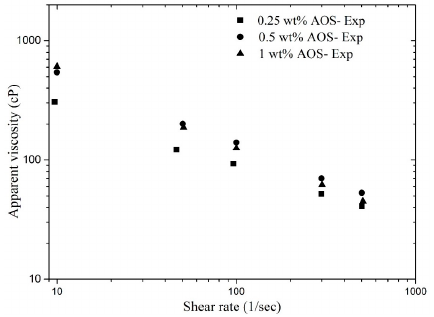
Figure 3. Effect of different alpha olefin sulfonate (AOS) concentration and shear rate on CO 2 foam apparent viscosity.